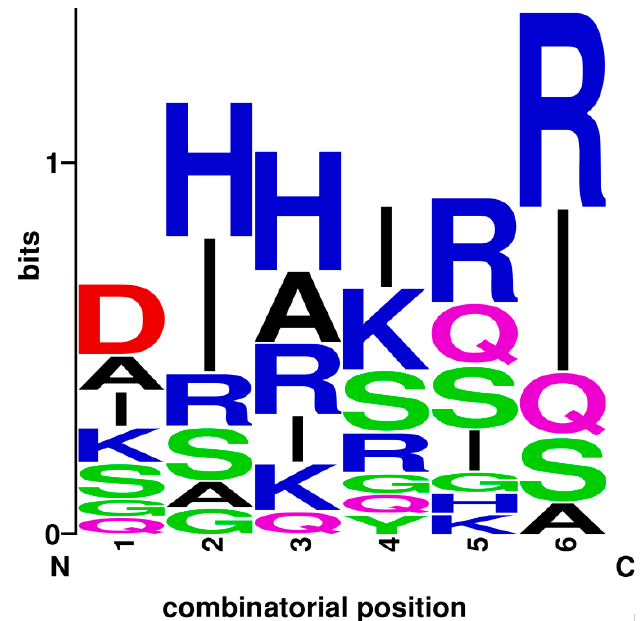
Figure A1. Representative fluorescence microscope images of library beads binding red- and green- labeled affibodies at different binding ratios.